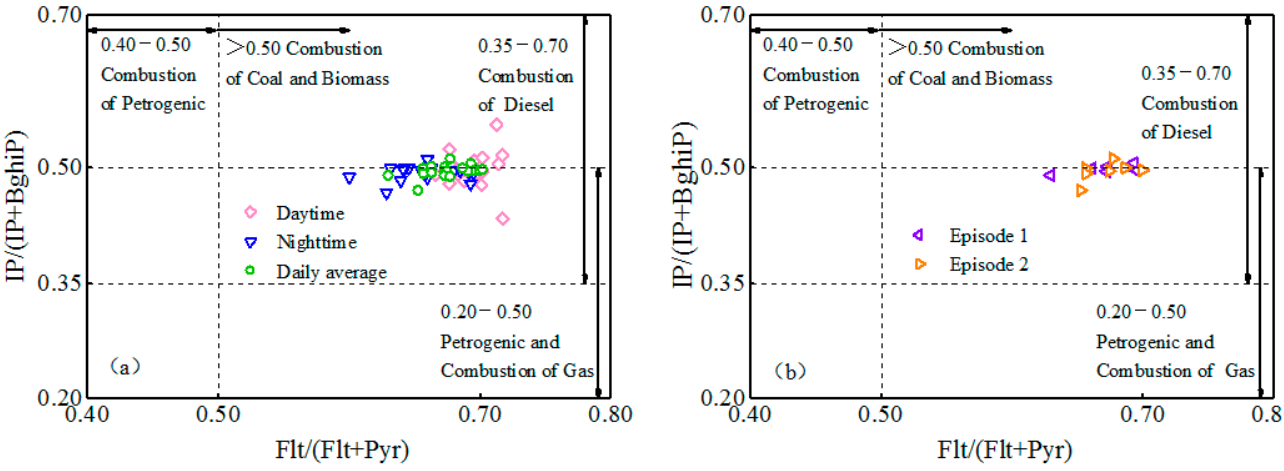
Figure 11. Variation of fluoranthene (Flt)/(Flt + pyrene (Pyr)) and indeno [1,2,3-cd] pyrene (IP)/(IP + benzo[ghi]perylene (BghiP)) during the monitoring period: ( a ) Flt/(Flt + Pyr) VS. IP/(IP + BghiP), ( b ) Flt/(Flt + Pyr) VS. IP/(IP + BghiP).